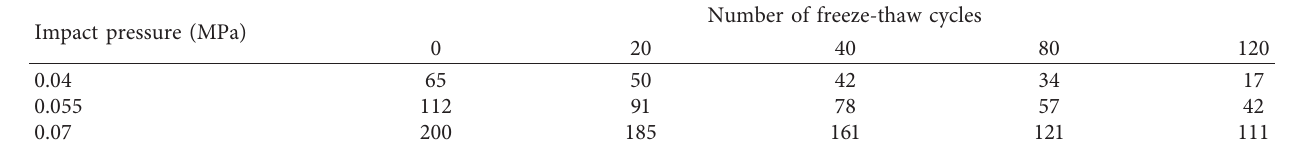
Table 2: Stress peaks of sandstone specimens under different impact pressures.